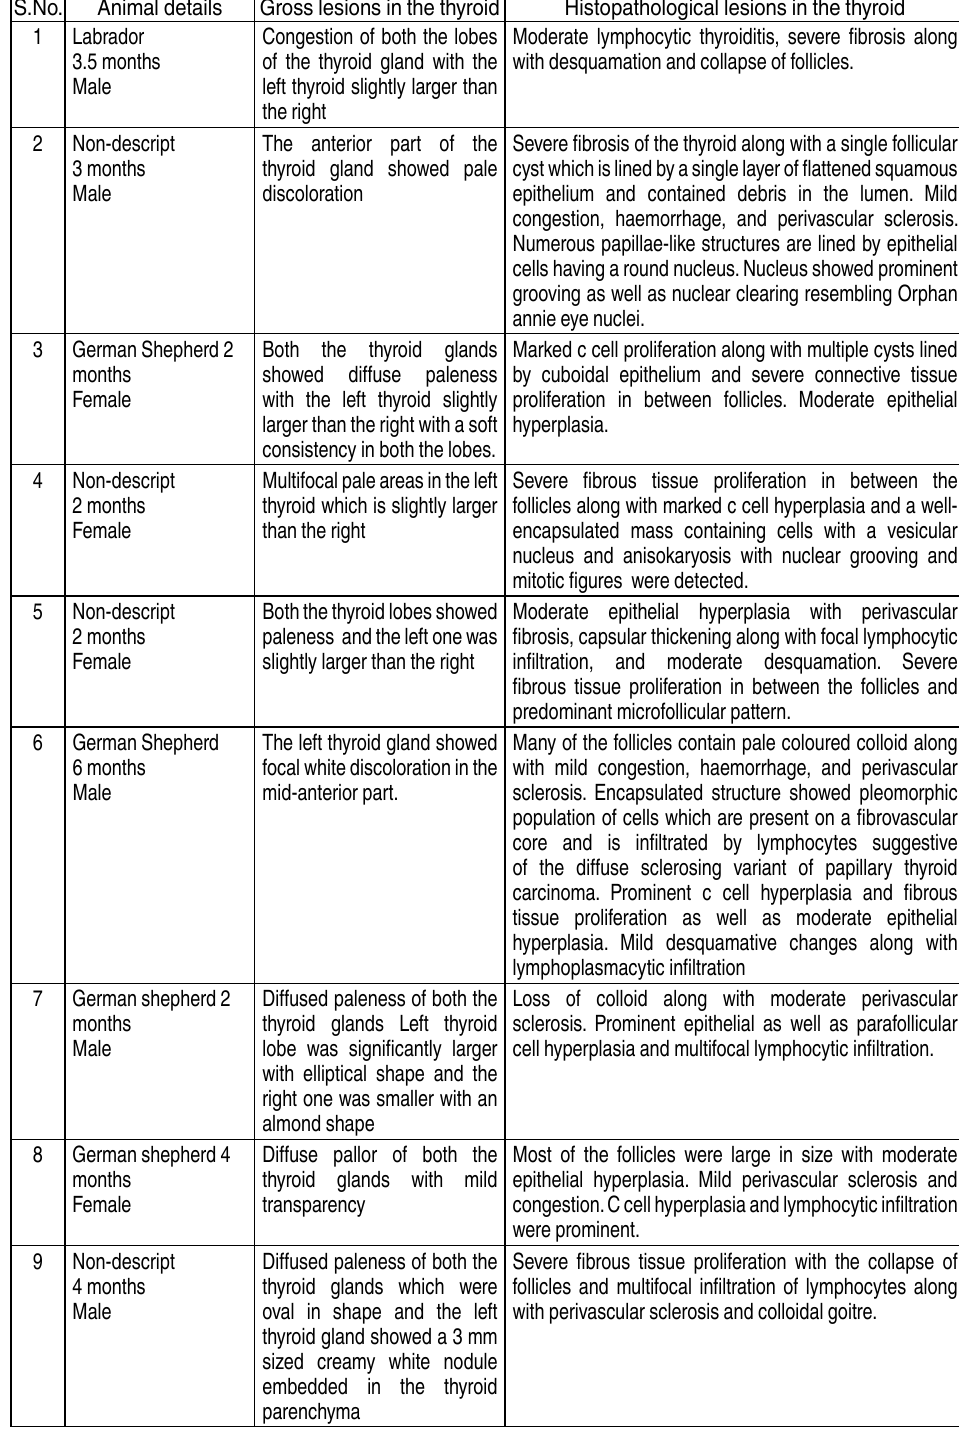
table 1 . Gross and Histopathological Lesions Observed in the Thyroid Gland of Canine